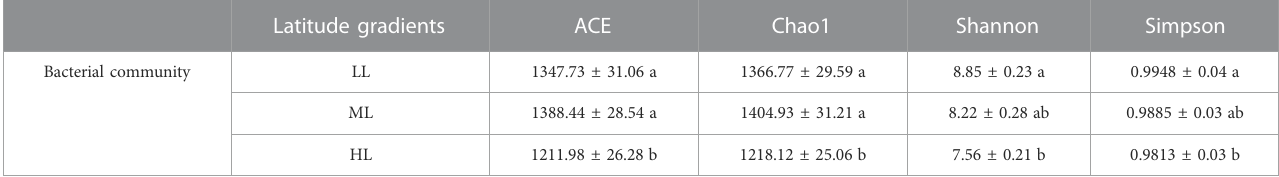
TABLE 3 α Diversity of the soil bacterial community at different latitudes. Latitude gradients ACE Chao1 Shannon Bacterial